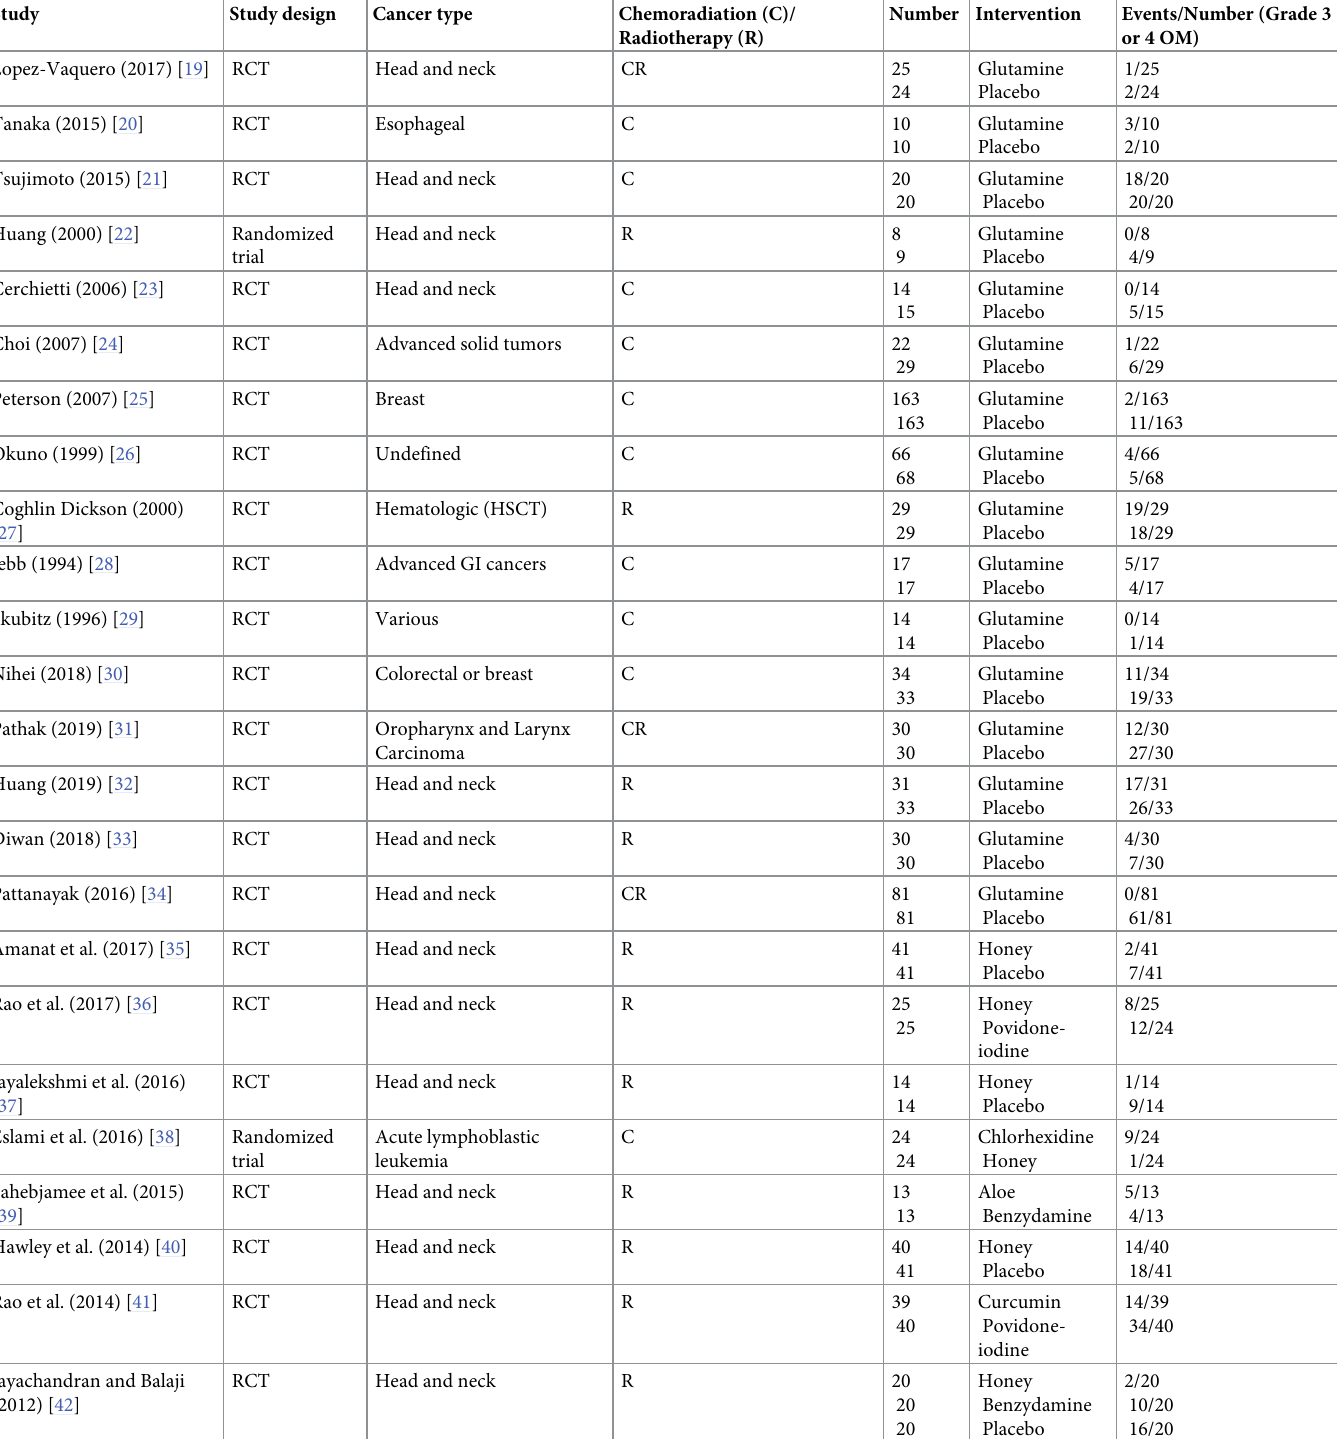
Table 1. Characteristics of included